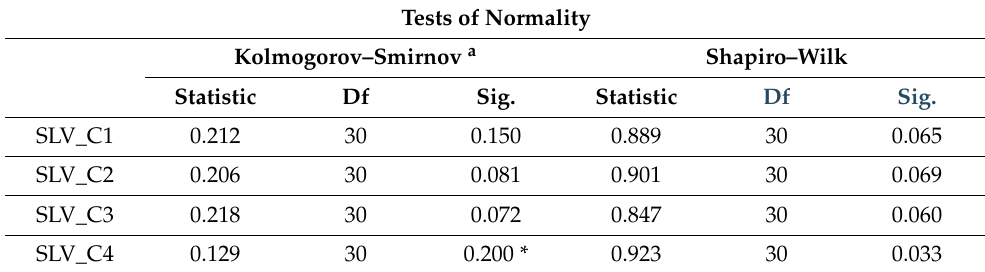
Table 8. Normality test on stop line violation.